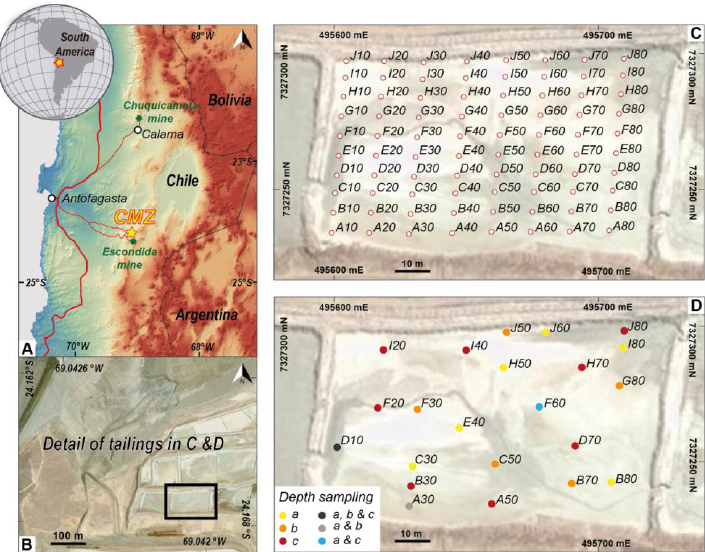
Figure 1. ( A , B ) CMZ tailings location, ( C ) regular sampling grid with 80 sites on CMZ tailings, ( D ) spatial distribution of tailings samples for chemical analyses. Green: depth a; blue: depth b; red: depth c; purple: three depths; yellow: depths a and b; light blue: depths a and c. The black box represents the study area within the tailing terrace.